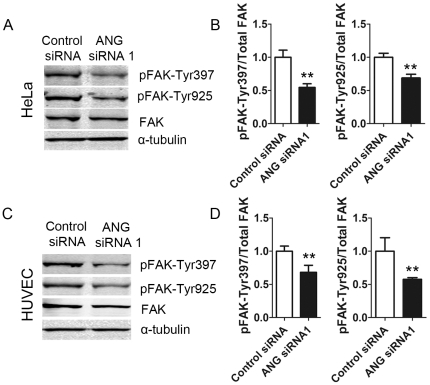
Down-regulation of ANG decreased FAK phosphorylation.HeLa cells (A) or HUVECs (C) were treated with ANG siRNA 1 or control siRNA. The cell lysates were subjected to immunoblot detection of pFAK-Tyr397, pFAK-Tyr925, FAK and α-tubulin. The densities of phosphorylated FAK bands were analyzed with Quantity One software and normalized to total FAK (B-HeLa cells, D-HUVECs). Data shown are the mean ± SD of three independent experiments.